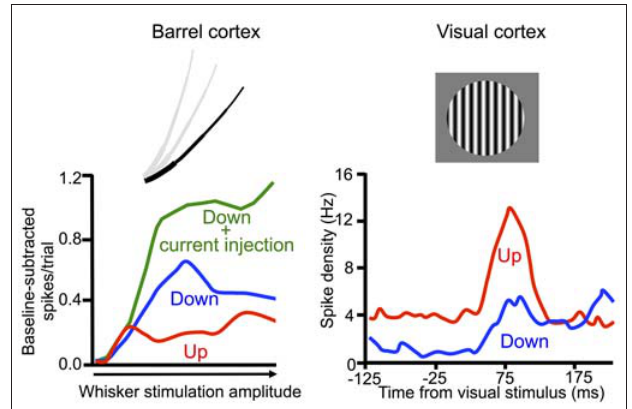
FIGURE 6 | Up states differentially affect sensory-evoked responses of cortical neurons in barrel and visual cortex. ( Left ) In rat barrel cortex, whisker stimulation evokes a proportionally larger spiking output during the Down state compared to the Up state. Decreased driving force due to depolarization during the Up state is unlikely to explain this effect since it is not seen with depolarizing current injection during the Down state. Network effects (e.g., thalamocortical synaptic depression or increased intracortical synaptic inhibition) are more likely to account for reduced responsiveness in barrel cortex neurons during the Up state compared to the Down state. ( Right ) Conversely, in cat visual cortex, drifting-grating stimuli evoke larger spiking output during Up states compared to Down states. Left adapted by permission from the Society for Neuroscience: Journal of Neuroscience (Hasenstaub et al., 2007), © 2007. Right adapted by permission from the American Physiological Society: Journal of Neurophysiology (Haider et al., 2007), ©